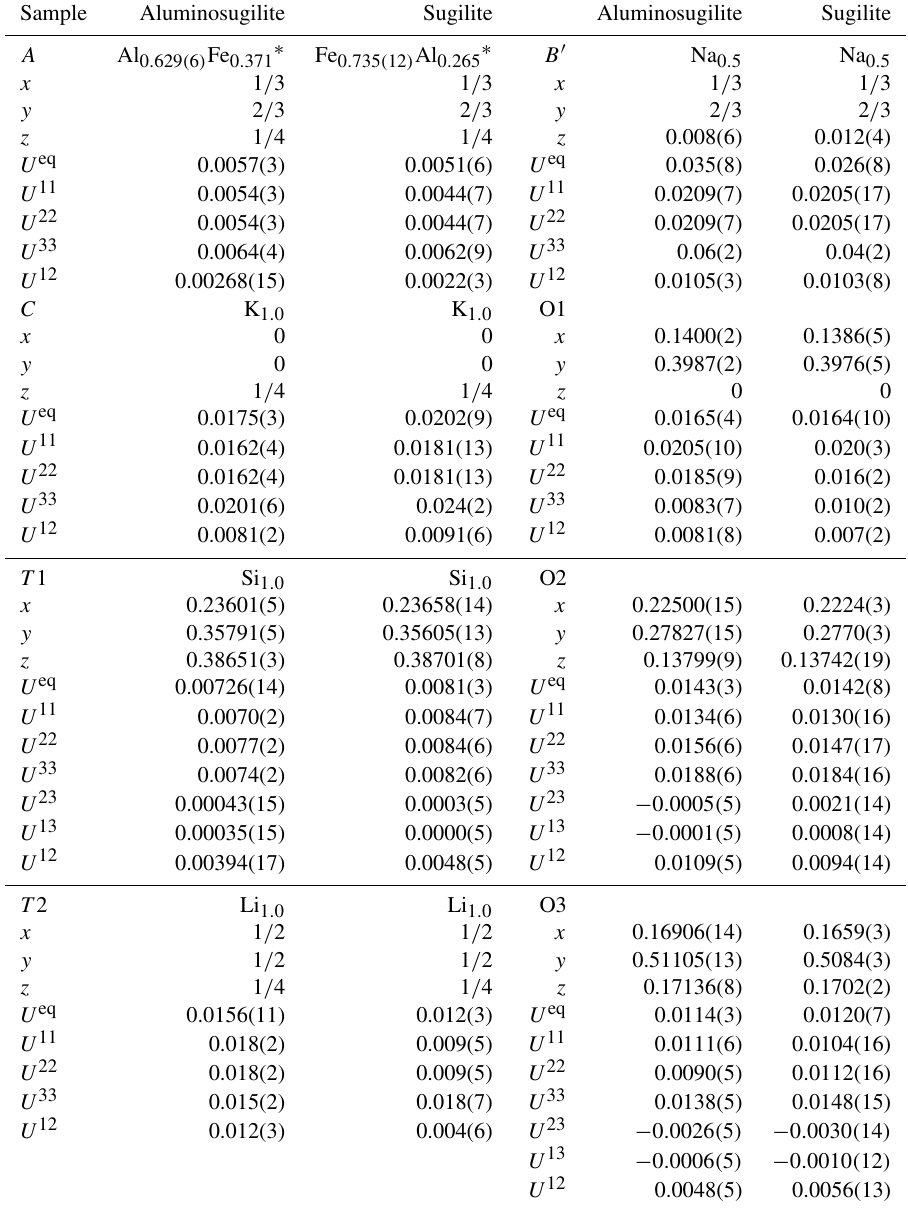
Table 3. Refined atomic coordinates, displacement parameters, and site occupancies of aluminosugilite and sugilite.